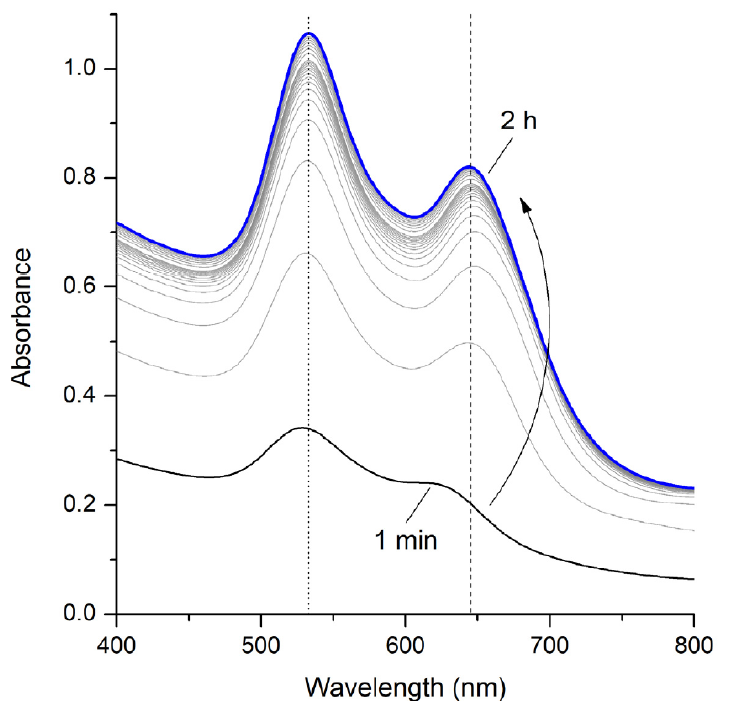
Figure 5. UV–VIS spectra showing the process of nanotriangle growth, selected wavelength positions at 533 and 645 nm are marked by dotted lines. The arrow indicates the time evolution.